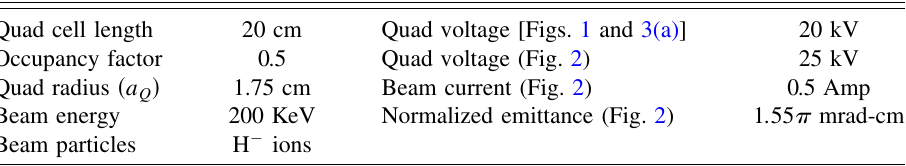
TABLE II. Parameters for Figs. 1–3, based on the actual MFE ESQ accelerator